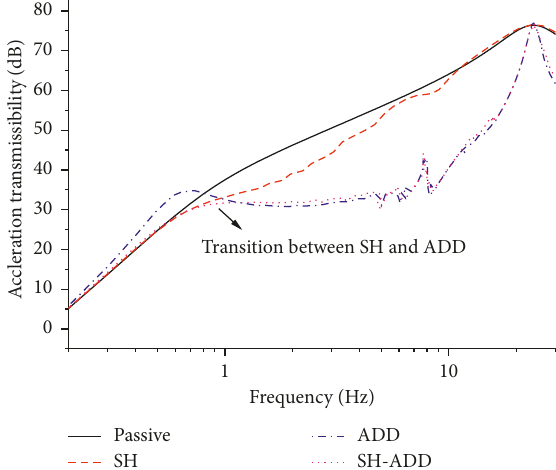
Figure 9: Performance of mixed SH-ADD control in the quarter